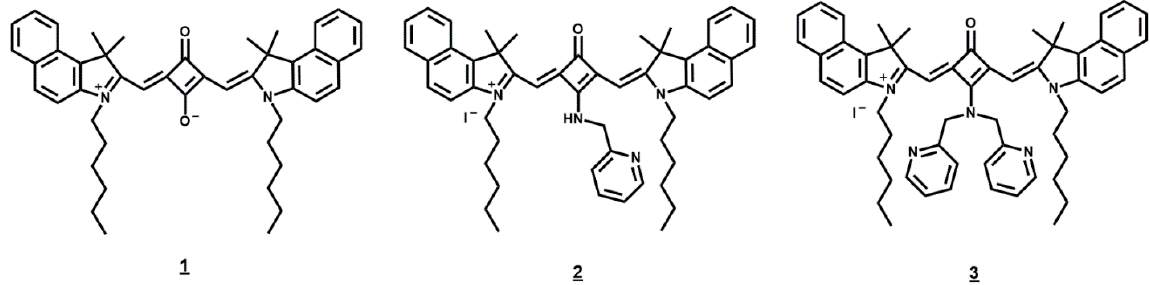
Figure 1. Squaraine dyes 1 – 3 , analog to those prepared in the present work, from which the objective is to make a comparative analysis [43].